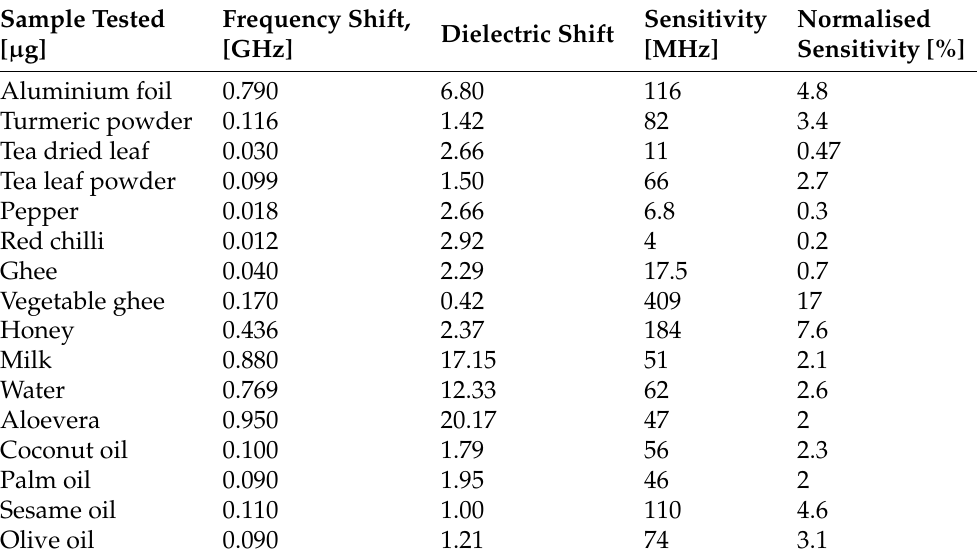
Table 14. Sensitivity chart on loading various samples.